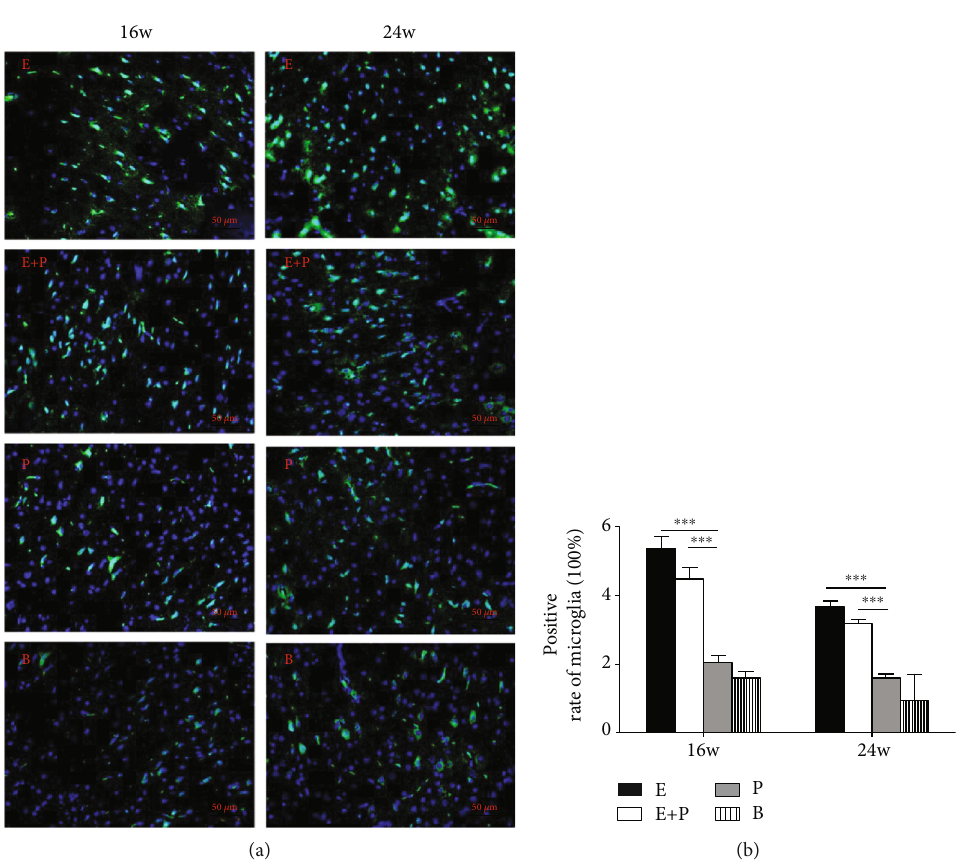
Figure 9: Immuno fl uorescence staining assay of microglia in the right PMC in 16 w and 24 w after surgery in di ff erent groups. (a) Immuno fl uorescence staining of Iba-1 (green). Scale bar = 50 μ m . (b) Positive rate of microglia cells in di ff erent groups. E: Iba-1 expression of the entire root group; E+P: Iba-1 expression of the entire root+posterior division group; P: Iba-1 expression of the posterior division group; B: Iba-1 expression of the blank control group. ∗∗∗ P < 0 : 001 . Data are expressed as mean ± SD (one-way ANOVA followed by